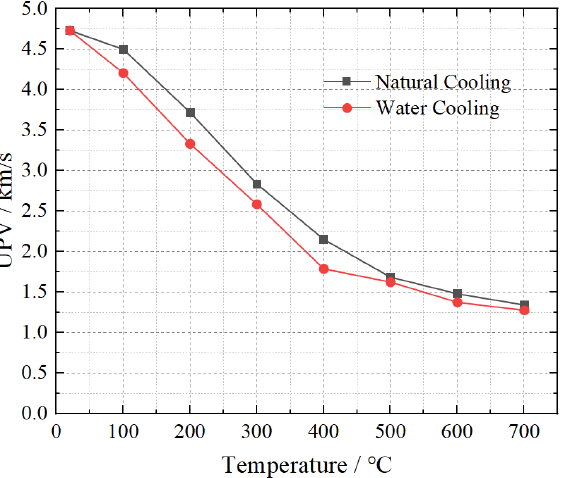
Figure 7. The UPV values of the SCC specimens after being cooled in water and air.